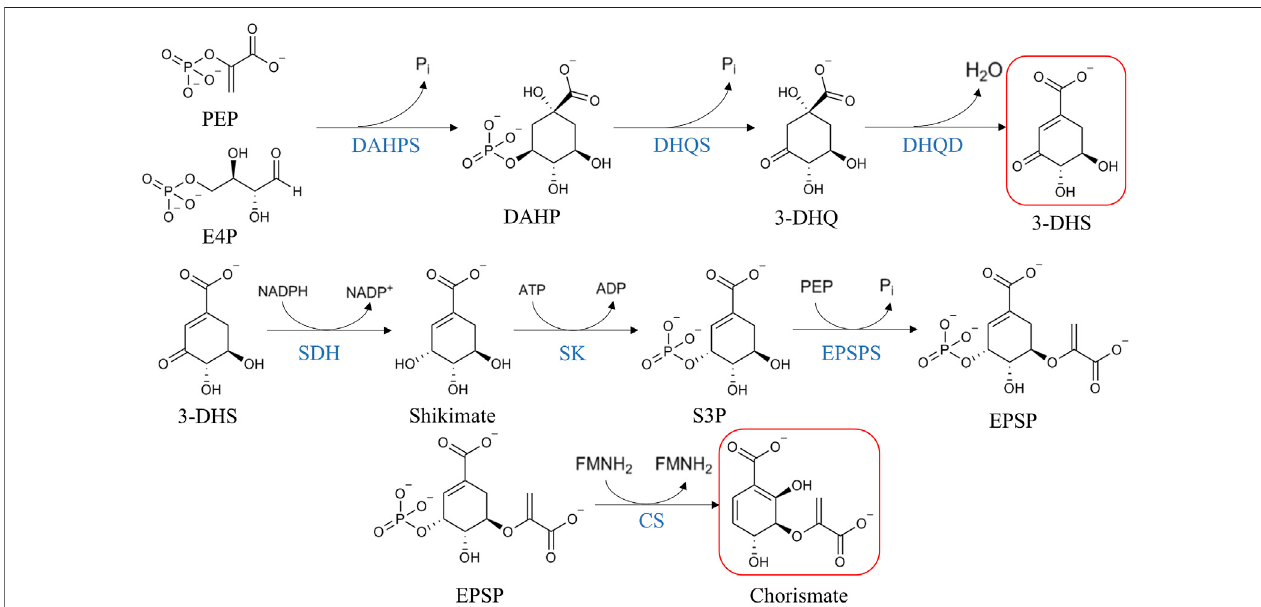
FIGURE 1 | Schematic of shikimate pathway reactions. 3-dehydroshikimate and chorismate are highlighted in red as the precursors of hydrolysable tannins and proanthocyanidins, respectively. Abbreviations: phosphoenolpyruvate (PEP), erythrose 4-phosphate (E4P), inorganic phosphate (P i ), 3-deoxy-D-arabino- heptulosonate-7-phosphate synthase (DAHPS), 3-deoxy-D-arabino-heptulosonate-7-phosphate (DAHP), dehydroquinate synthase (DHQS), 3-dehydroquinate (3- DHQ), 3-dehydroquinate dehydratase (DHQD), 3-dehydroshikimate (3-DHS), shikimate dehydrogenase (SDH), shikimate kinase (SK), shikimate-3-phosphate (S3P), 5-enolpyruvylshikimate 3-phosphate synthase (EPSPS), 5-enolpyruvylshikimate-3-phosphate (EPSP), and chorismate synthase (CS). Adapted from Vogt, 2010; Akagi et al., 2011; Mir et al., 2015; Stefanachi et al.,